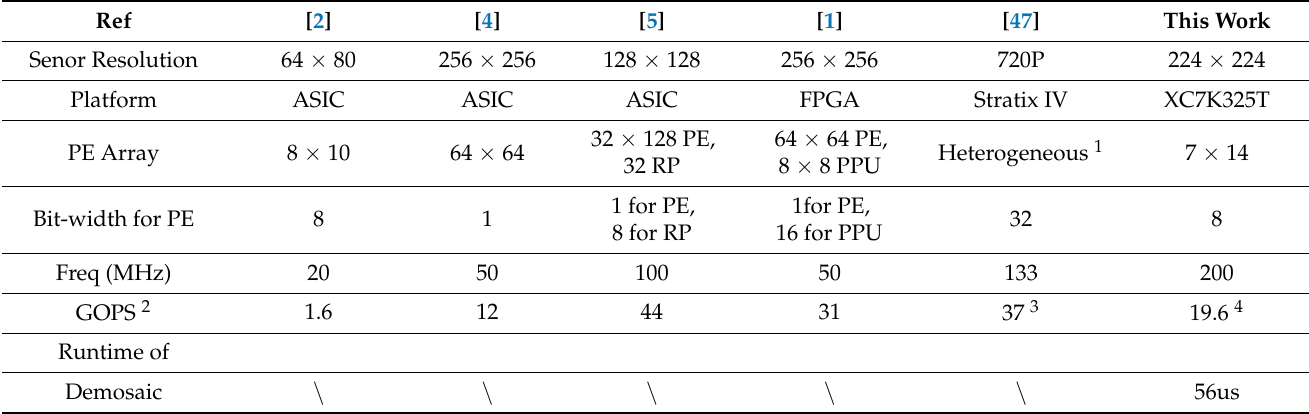
Table 3. The experiment results for the ISP tasks and the comparison with other